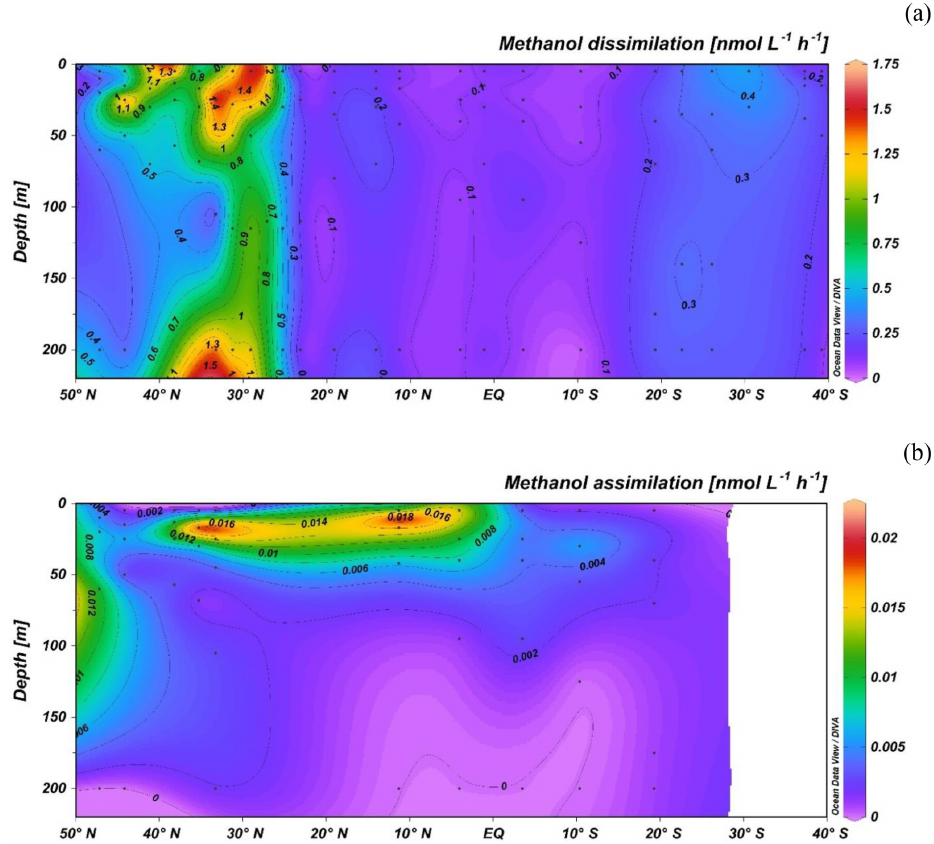
Figure 4. Microbial methanol (a) dissimilation and (b) assimilation rates (nmolL − 1 h − 1 ) in the top 200m of an Atlantic Meridional Transect voyage (contour plots).